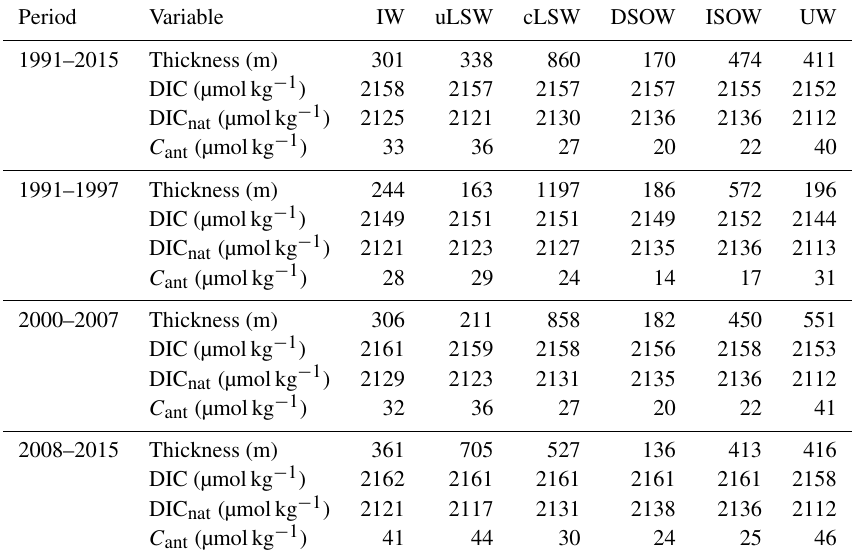
Period Variable